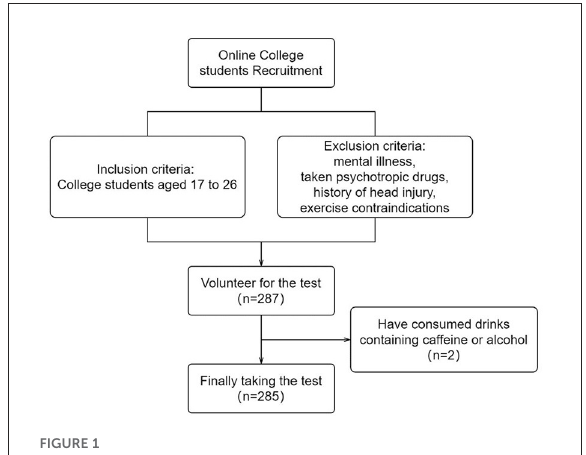
FIGURE1 Flow chart for participant recruitment.